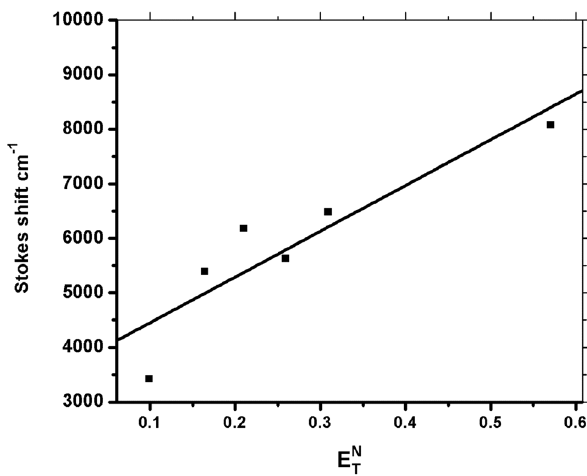
Figure 5: Plot of E TN versus Stokes shift ( cm − 1 )